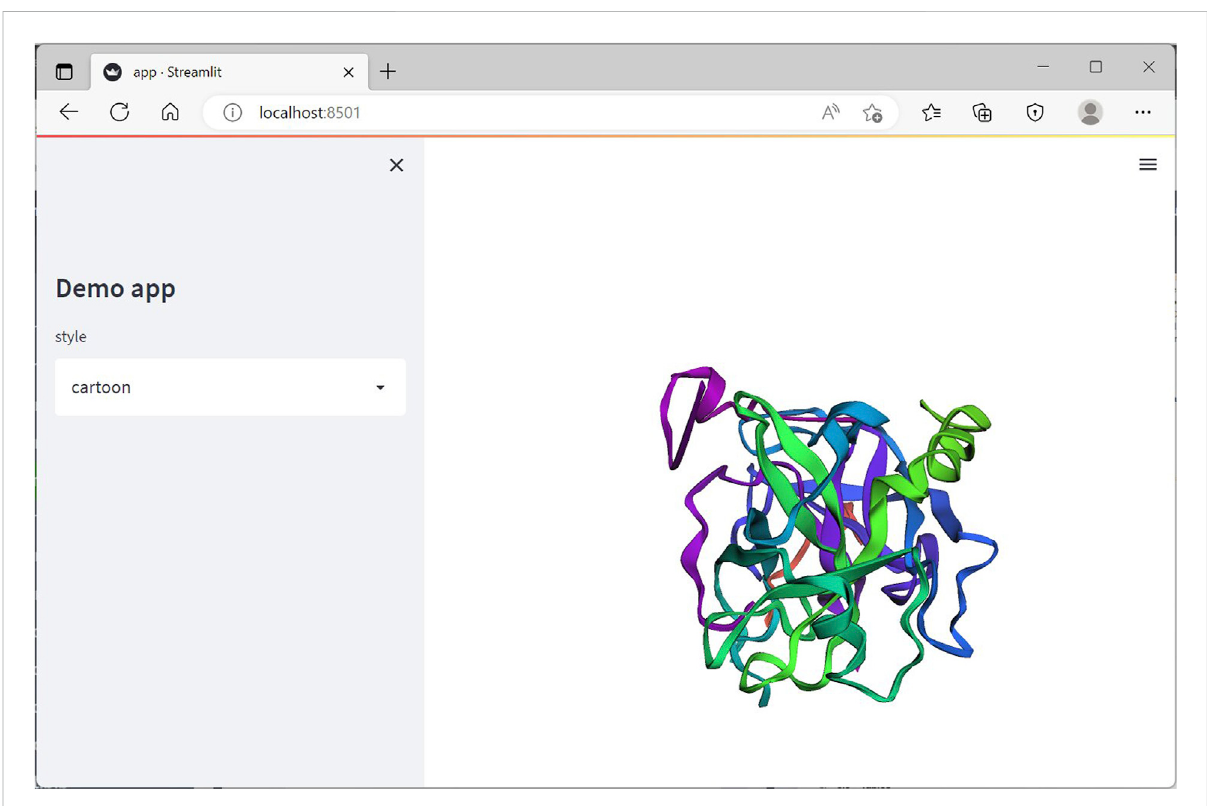
FIGURE 5 Streamlit web-app running on the browser on local server on executing the app.py Python fi